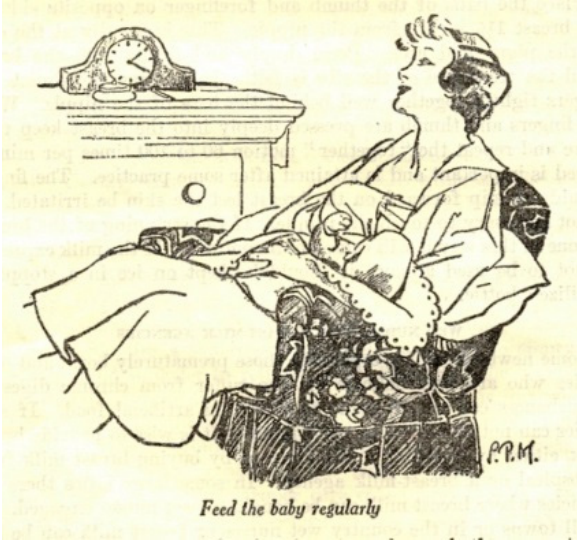
Figure 6. Nursing “By the Clock”.